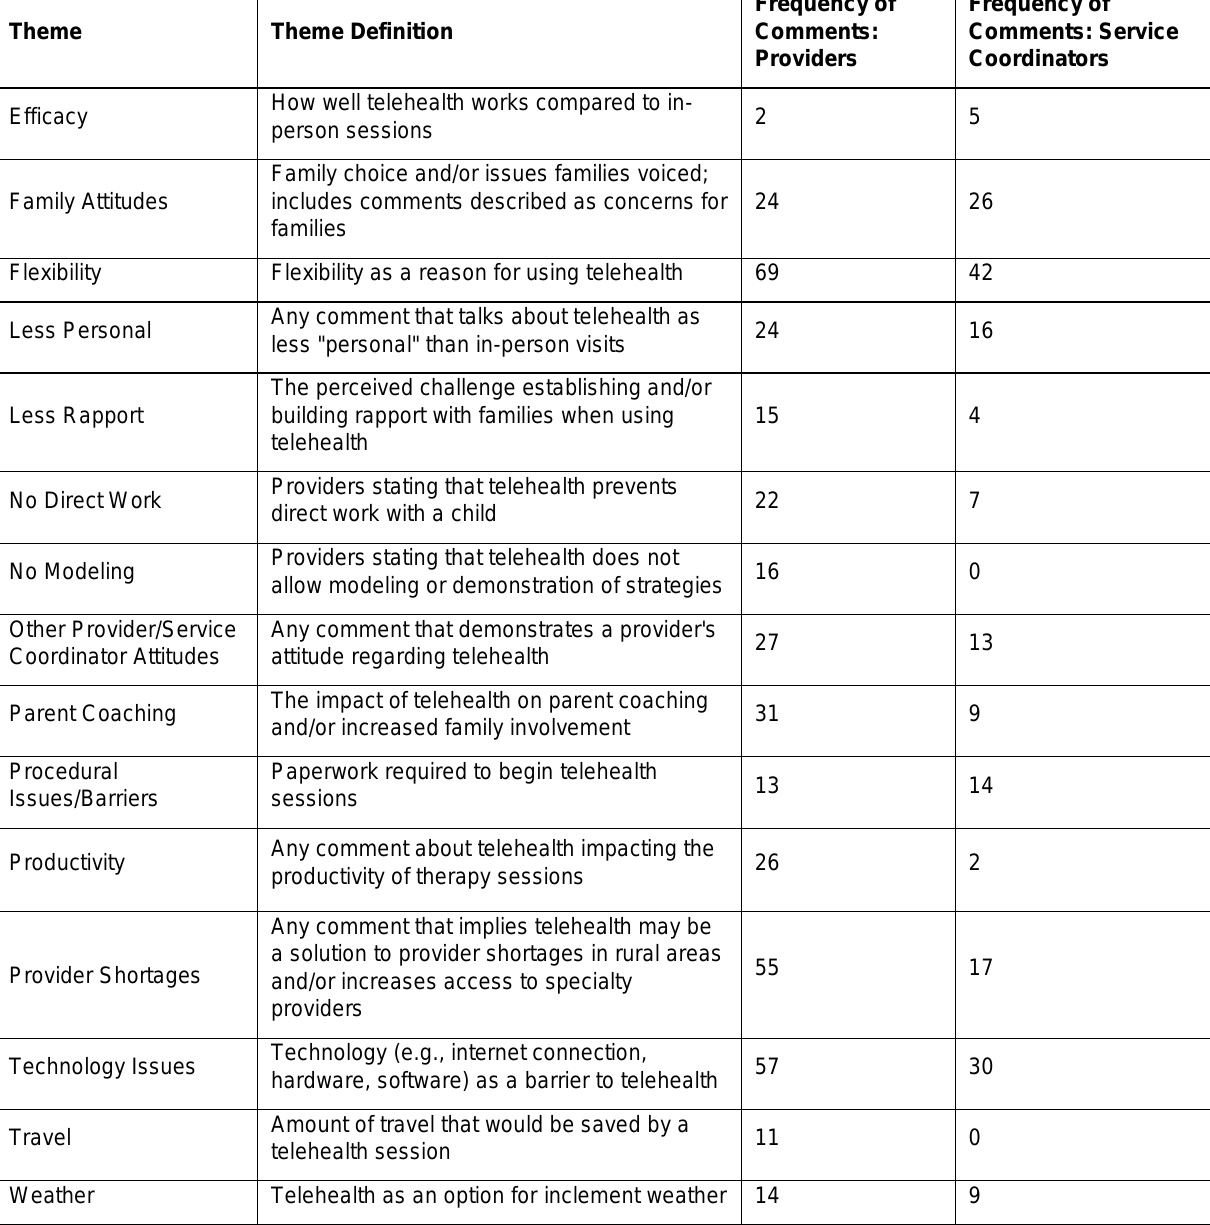
Table 1. Themes and Frequency of Occurrence from Survey Data